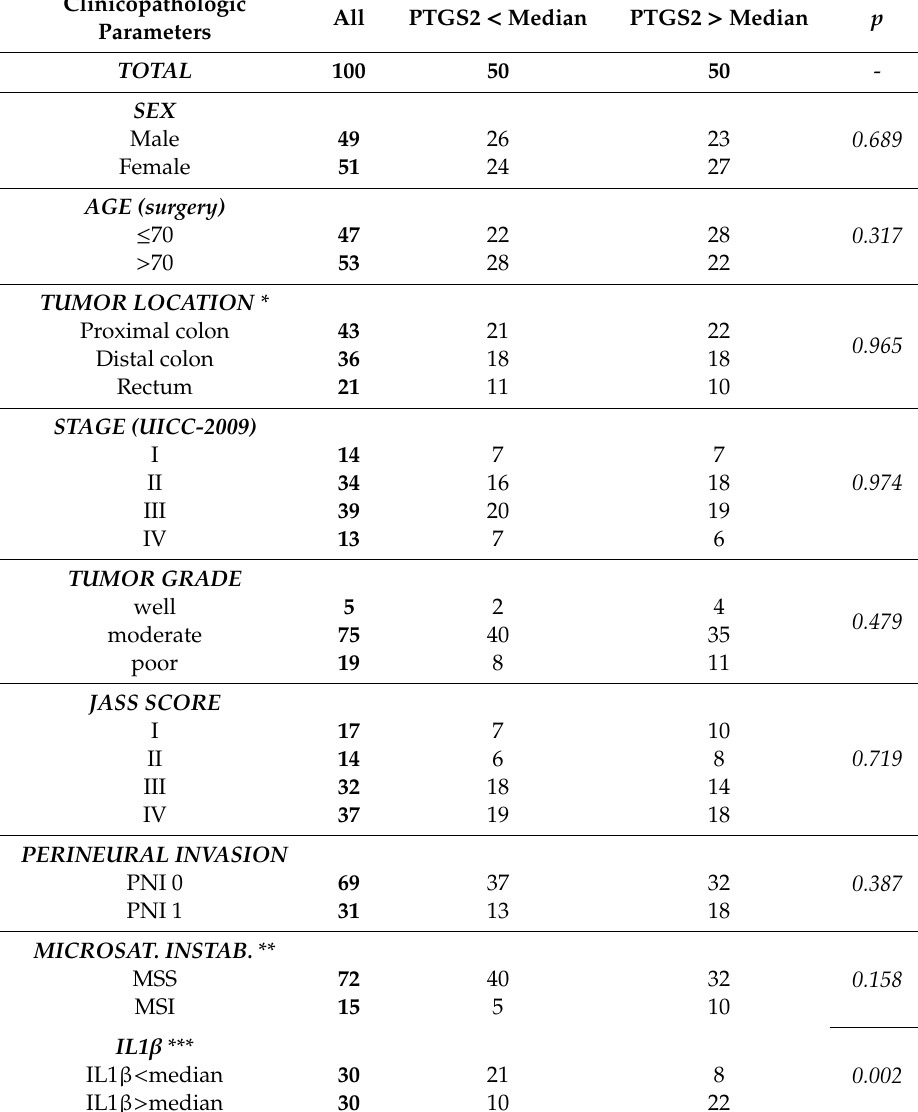
Table 1. Clinical and molecular features of CRC according to median PTGS2